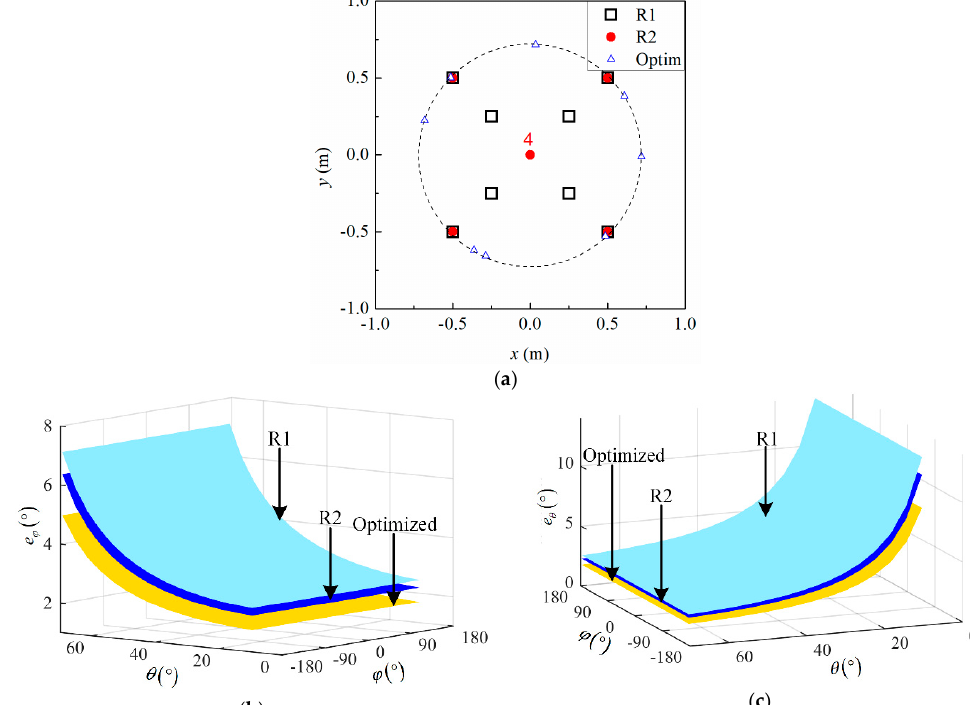
Figure 13. Comparison of optimized and reference arrays for direction-of-arrival (DOA) estimation: ( a ) array deployments; ( b ) Cramér-Rao lower bound (CRLB) of azimuth angle; ( c ) CRLB of elevation angle.